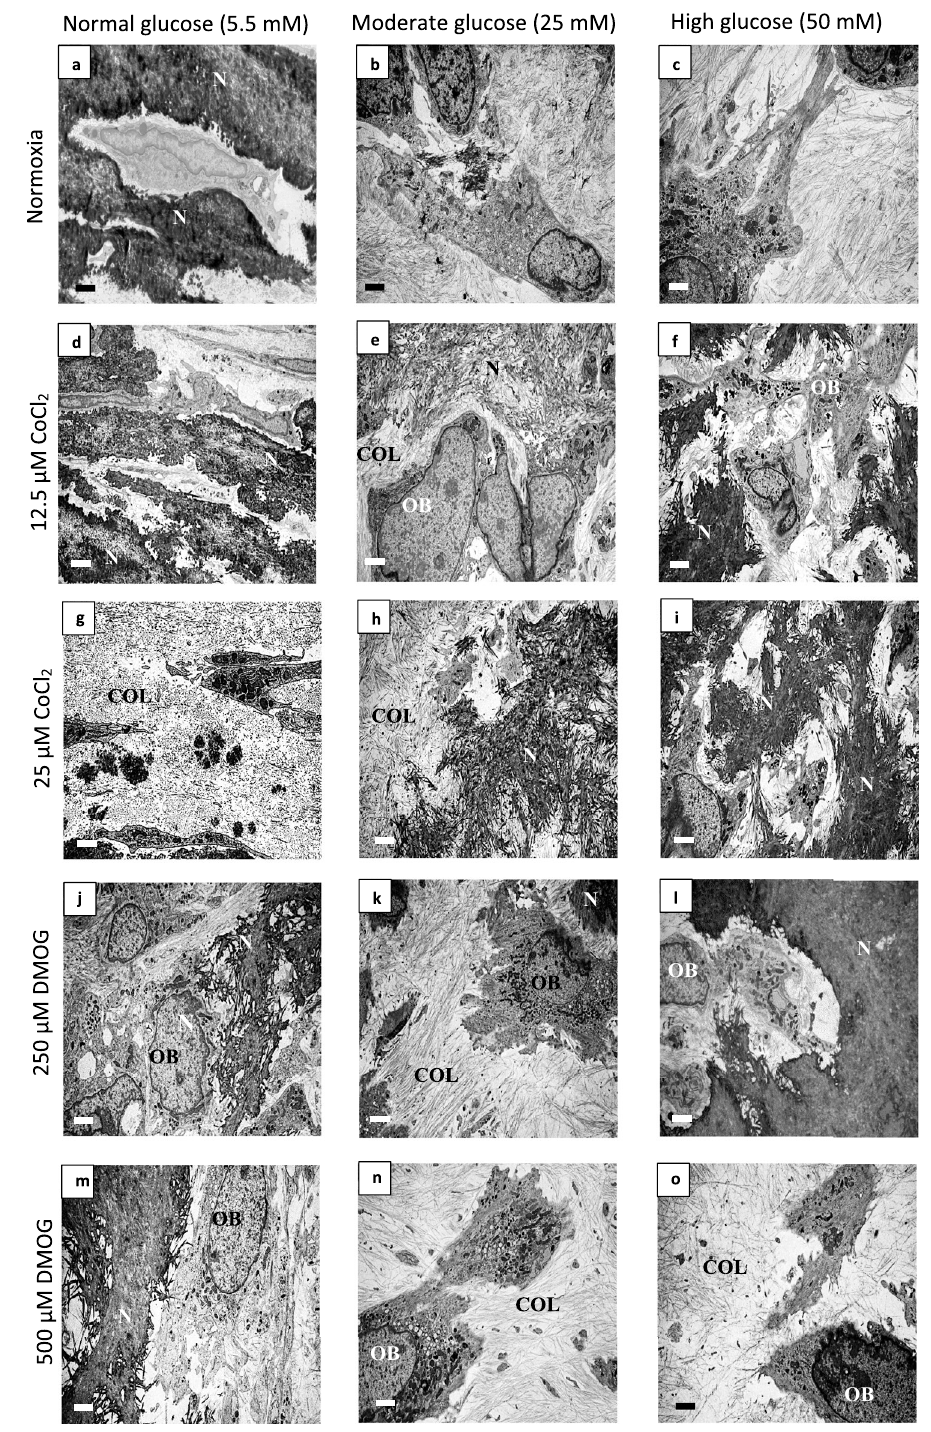
Figure 4. The effects of HIF-1α mimetics and differing glucose environments on the ultrastructure of bone nodules. Transmission electron microscopy (TEM) of ( a – c ) moderate and high glucose levels showed reduced extracellular mineralised collagen fibres compared to normal glucose in normoxia. The HIF-1α mimetics ( d , j ) CoCl 2 and ( j , m ) DMOG, reduced extracellular mineralised collagen in normal (5 mM glucose conditions) but restored extracellular (bone-like) mineral in ( e , k , h ) moderate (25 mM) and ( f , i , l ) high (50 mM) glucose conditions compared to ( a – c ) untreated controls (with the exception of o ) 500 mM DMOG where no extracellular mineralised collagen fibres were observed. Scale bar for all images is 200 µm. (n = 5) (N: nodule, COL: collagen fibres, OB: